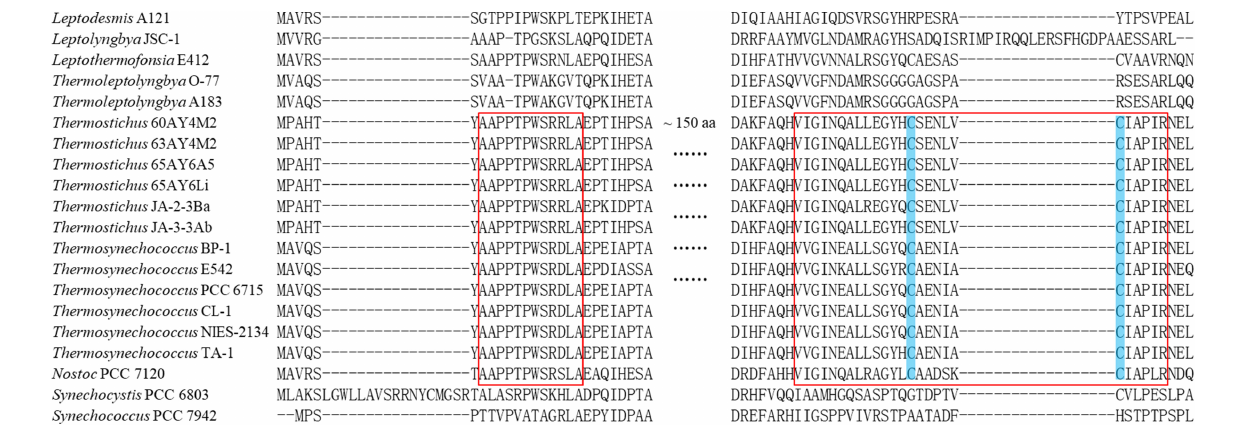
uptake (Han et al., 2017), whether and how such organization in Thermosynechococcus TA-1 affects the co-regulation requires further experimental elucidation. In addition, the genes encoding bicA1 and bicA2 were positionally scattered in the genomes of Leptothermofonsia E412 and Thermoleptolyngbya A183, whereas genes encoding cmpABCD and sbtA/B were located together in genomes ( Figure 7 ), respectively.